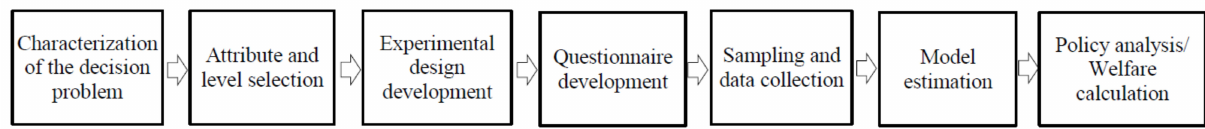
Figure 3. Source: Champ et al. [22]. CE design and valuation